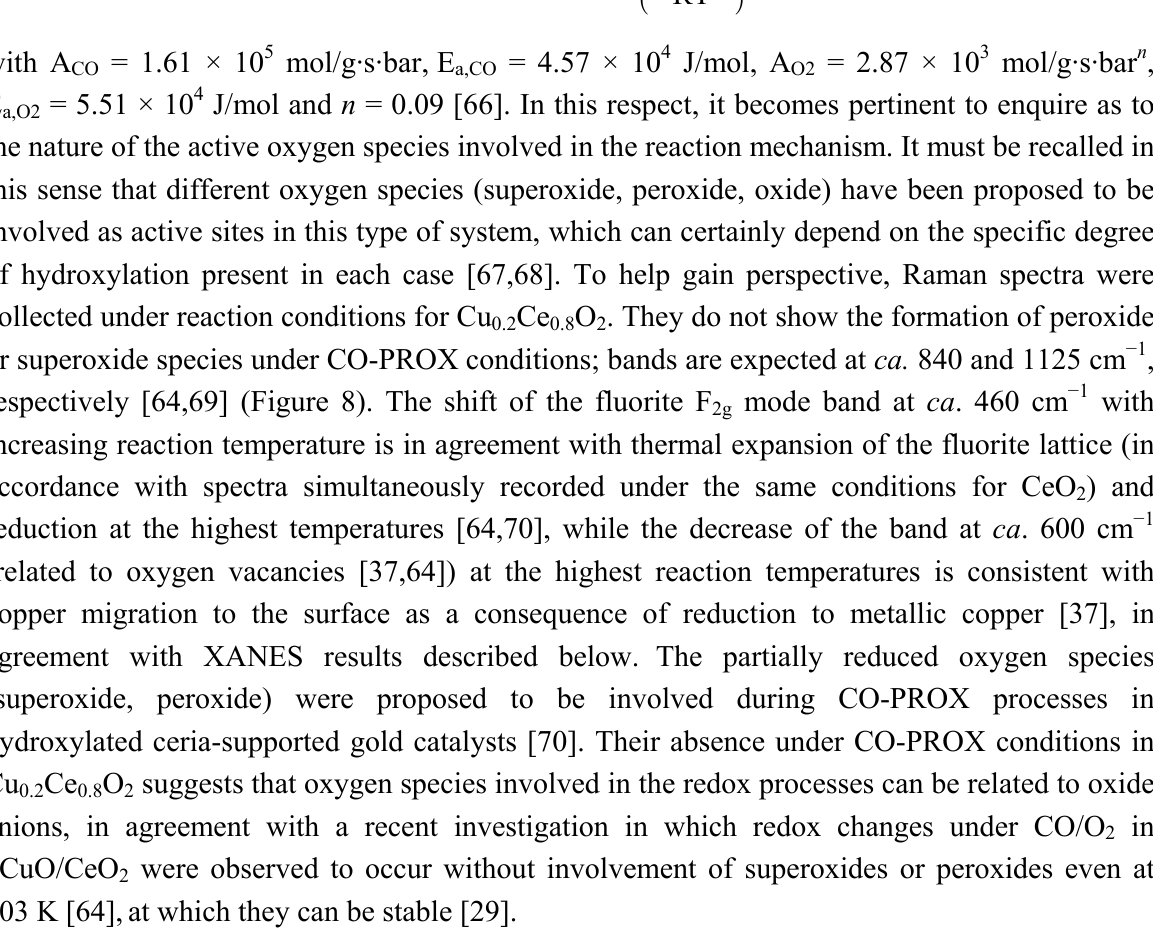
Cu O under CO-PROX conditions 0.8 0.2 2